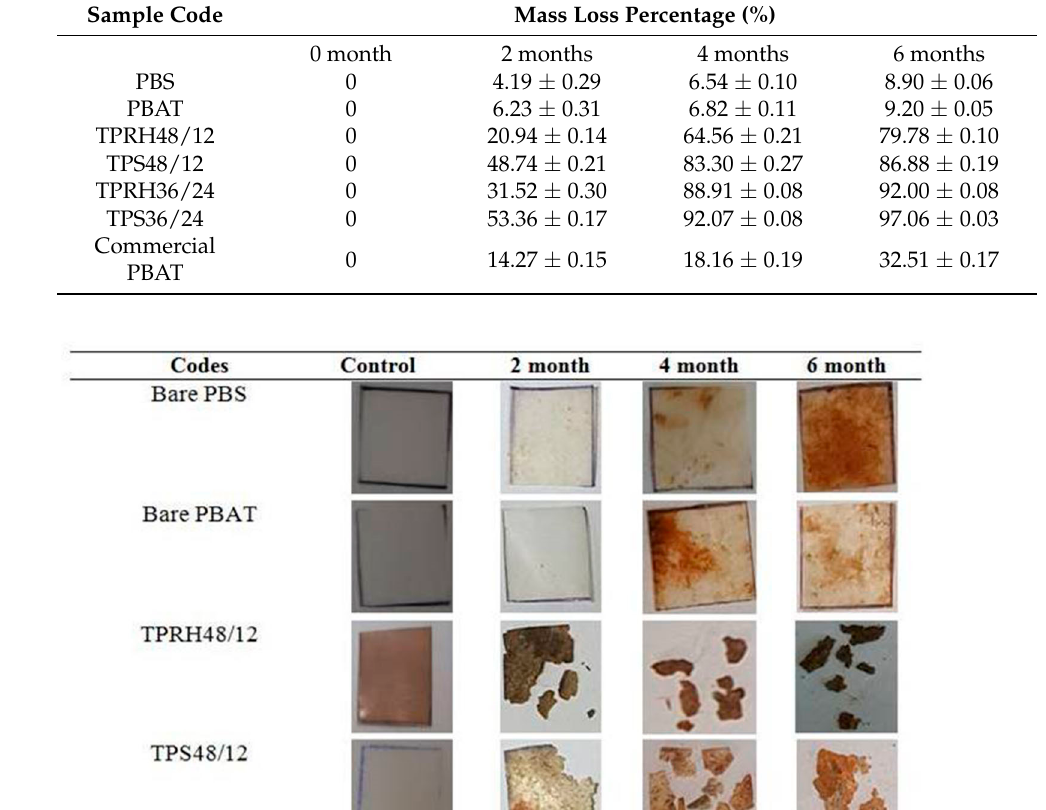
Table 5. Mass loss percentage of PBS/PBAT blends after soil burial test for six months.